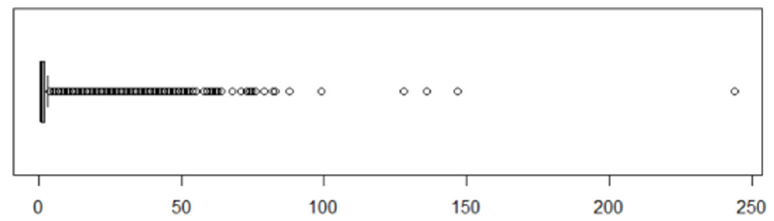
Figure 4. Accumulated number of visits per unique patient.